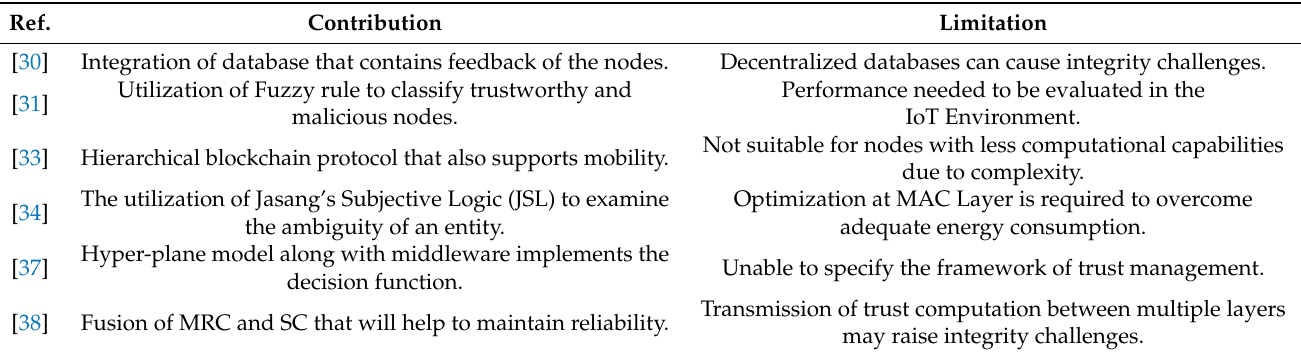
Table 1. The comparative analysis of the existing approaches.